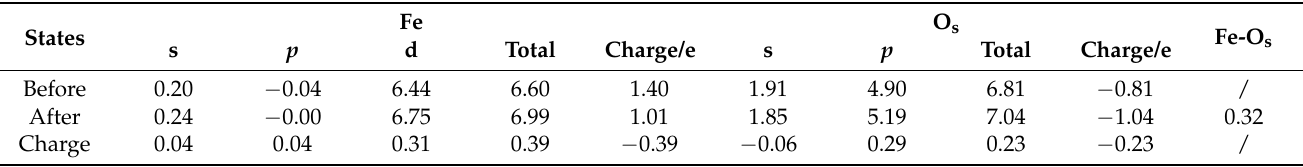
Table 6. Mulliken charge populations of monodentate adsorption, and Mulliken overlap populations of Fe-O s